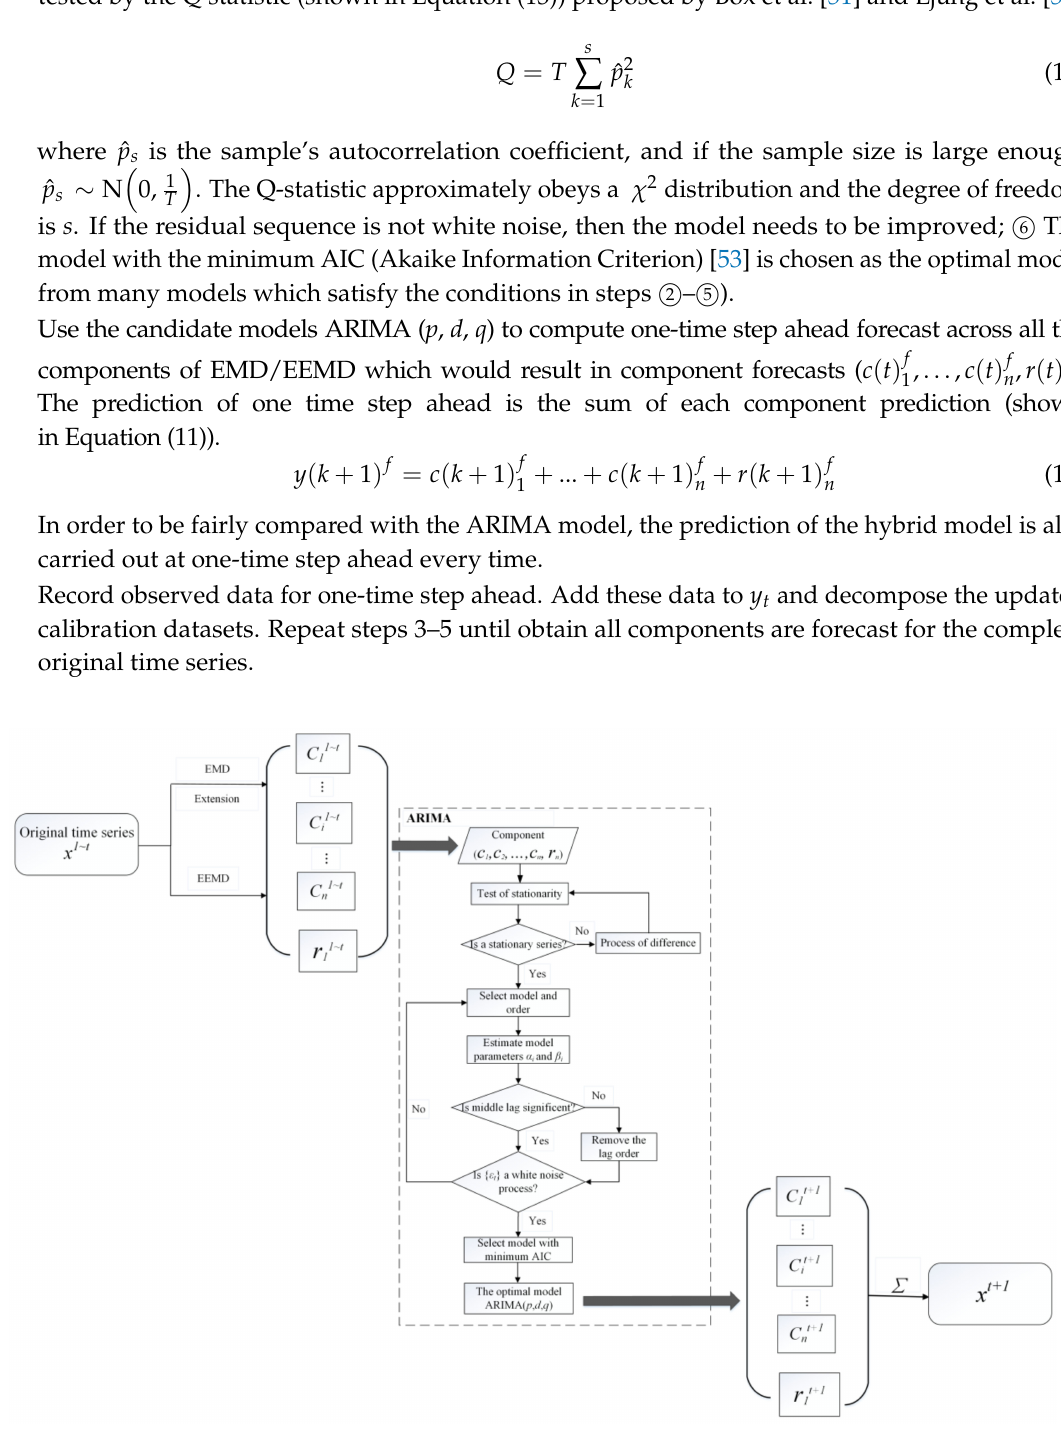
Figure 1. Flowchart of the EMD/EEMD-ARIMA hybrid method for time series